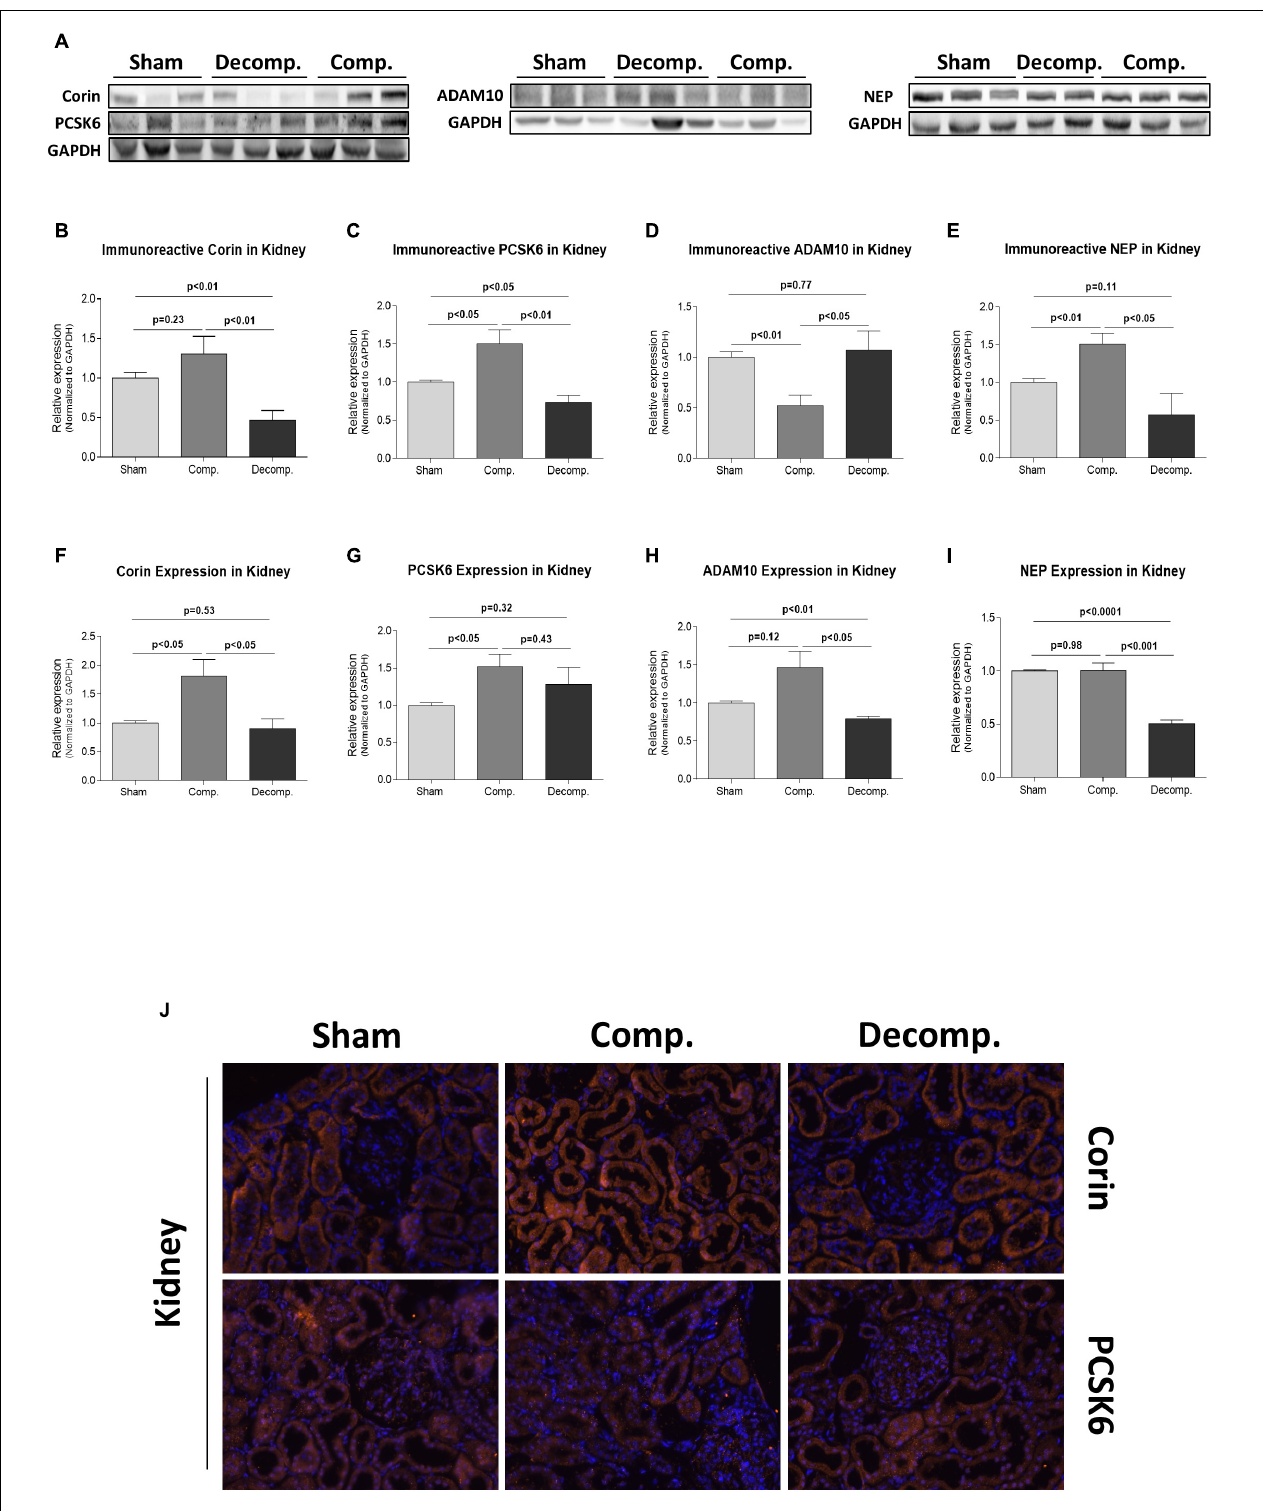
FIGURE 5 | Natriuretic peptide machinery system in the renal tissue of ACF and sham-operated rats. Representative western blot analysis (A) with antibodies against corin, PCSK6, ADAM10, and NEP and their quantification relative to GAPDH (B–E) in the kidney of ACF rats and their sham operated rats. (F–I) represents quantification of qPCR analysis of the mRNA of these enzymes relative to GAPDH. (J) Representative images of immunostaining of corin and PCSK6 in the kidney of the various animal groups, counterstained with DAPI. All images were obtained at x40 magnification. Values are presented as means ± SEM.